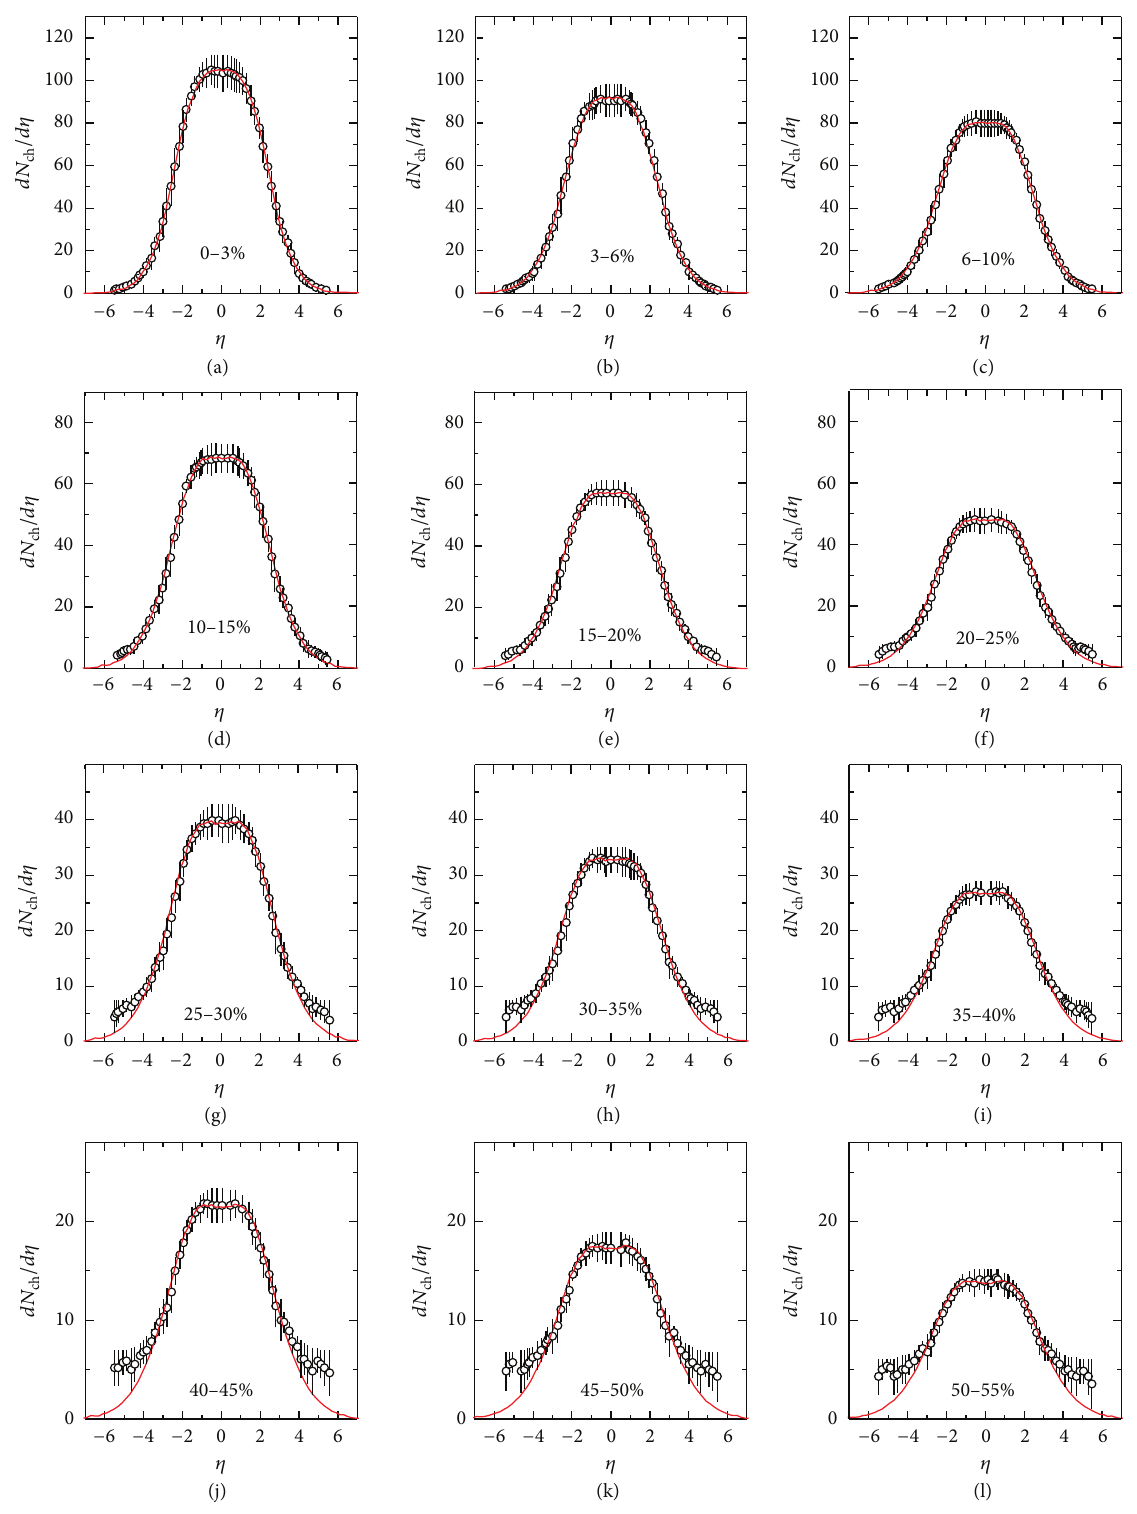
Figure 5: The same as Figure 1 but showing the results of Cu-Cu collisions at √ 𝑠 NN = 22.4 GeV. In the calculation, spectator contributions